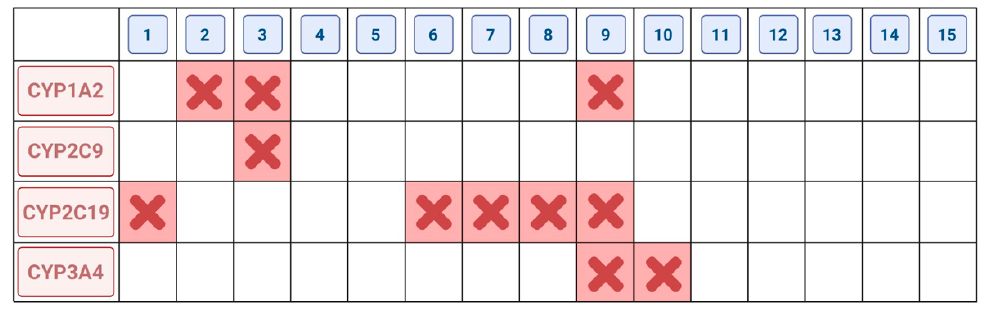
Figure 12. ADME analysis. CYP inhibitor prediction of fluconazole 1 , lactones 2–4 , analogues of fluconazoles 5–15 based on their chemical structure. Only 8 of them show inhibition of CYPs.